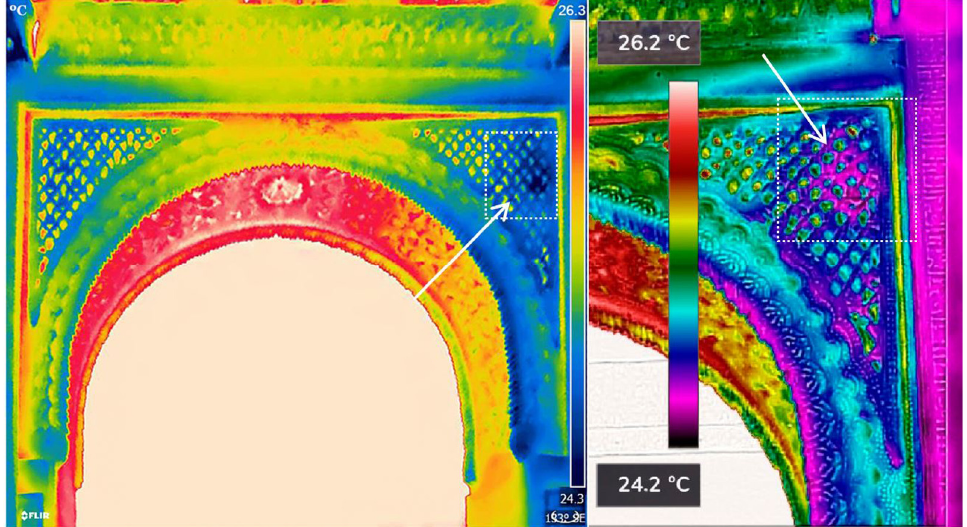
Figure 11. Thermography of the case study under ambient conditions of 23.5 °C and 61% relative humidity (images taken by the author on 27 June 2020 at 11 am).